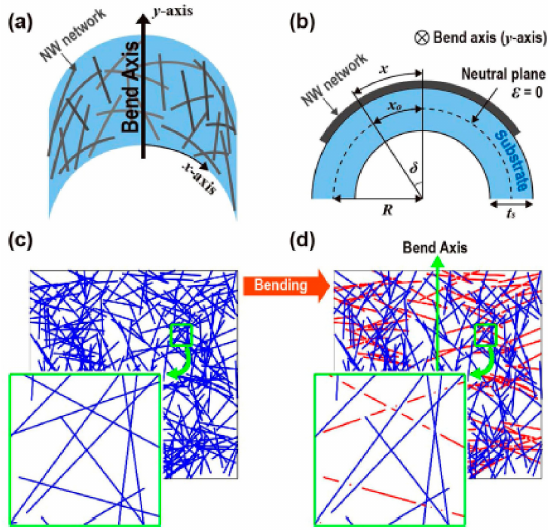
Figure 25. MC simulation of electrical conductivity of GRPCs under bending. ( a ) Network under outward bending; ( b ) Cross-sectional view of network under outward bending; ( c ) Network by MC simulation; ( d ) Simulation image represents network. Reproduced with permission from